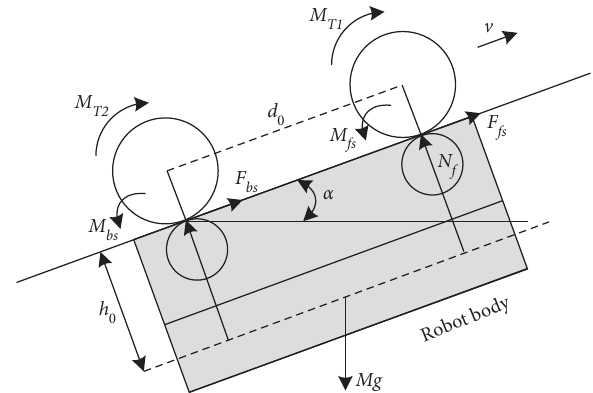
Figure 1: Statics model of the robot going